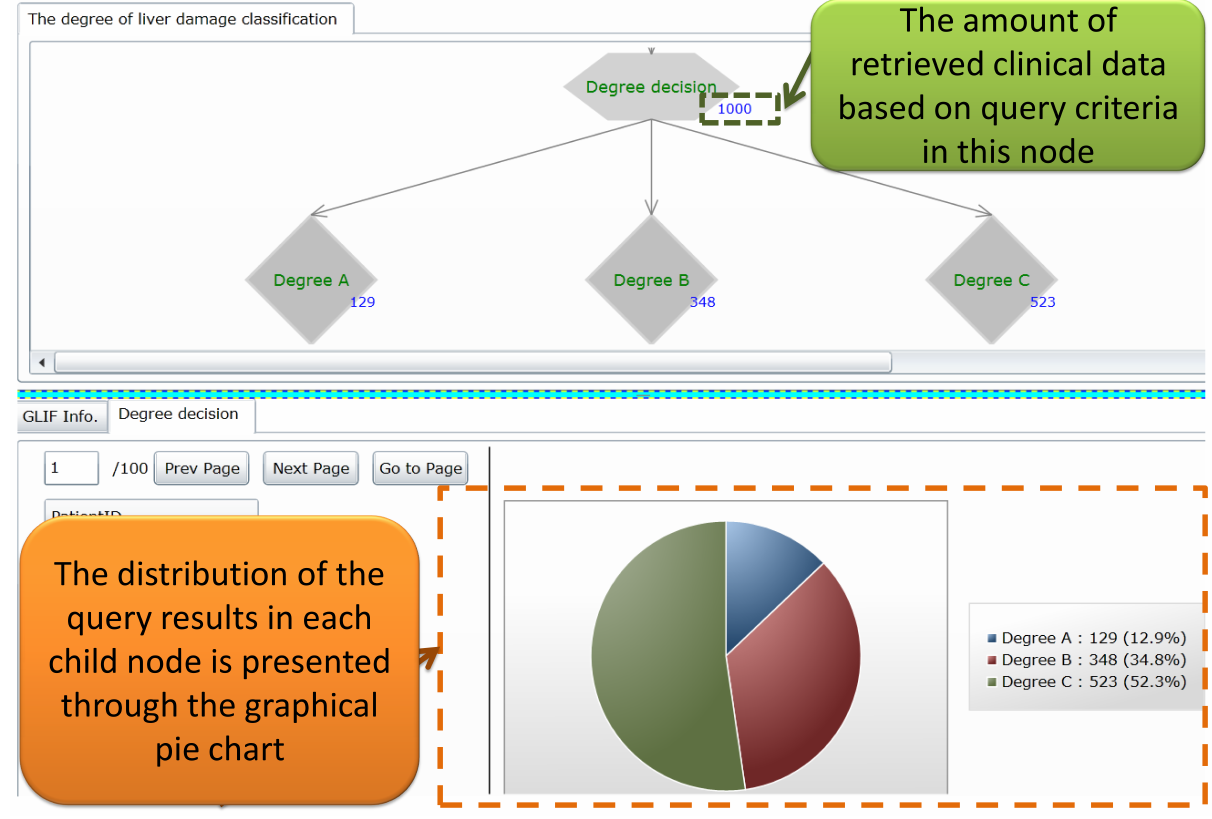
Figure 9. The clinical data representation interface showing the retrieved results of “degree of liver damage when applying a mutually exclusive setting” query